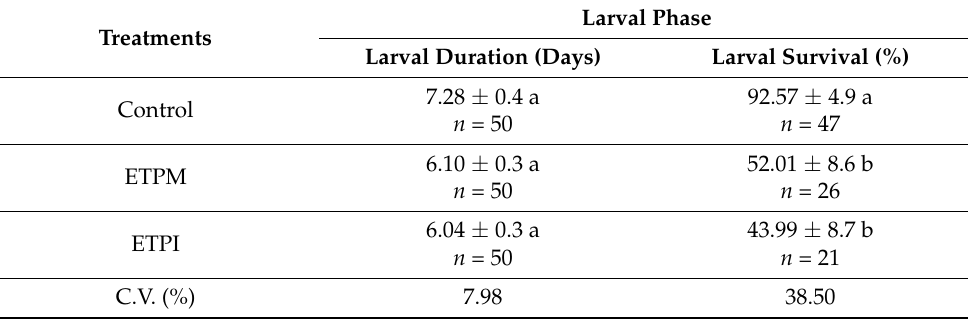
Table 1. Duration and larval survival ( ± standard error) of Plutella xylostella in plastic tunnels exposed to different treatments consisting of 10% Tradescantia pallida aqueous extract (Temp: 23 ± 8 ◦ C, RH: 53 ± 10%, photophase: 13 h ± 36